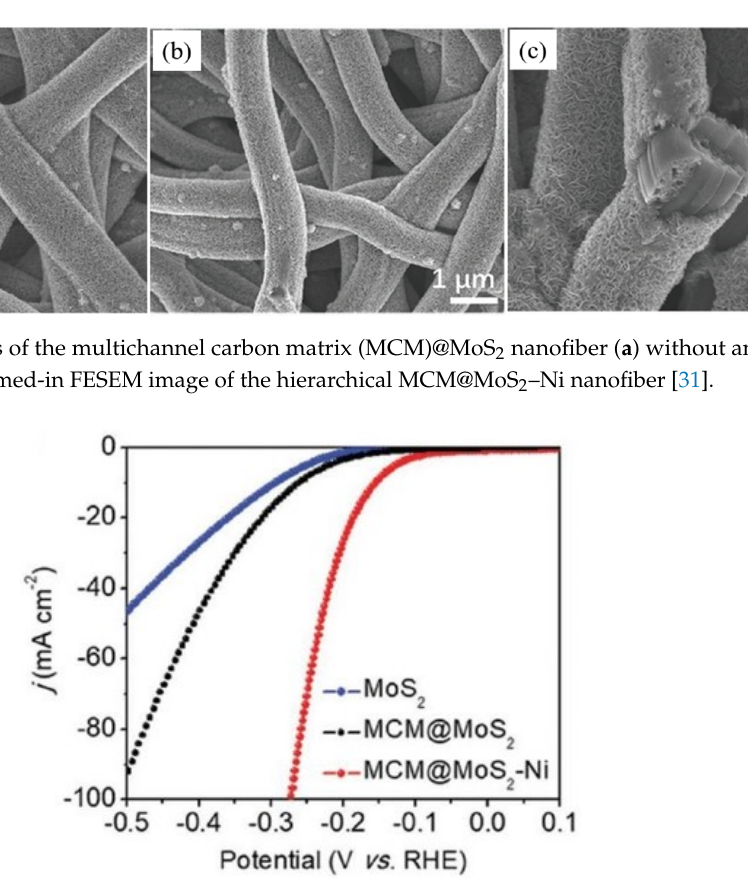
Figure 14. LSV curves of MoS 2 (blue line), MCM@MoS 2 (black line), and MCM@MoS 2 -Ni (red line) in 0.5 m H 2 SO 4 aqueous solution [31].